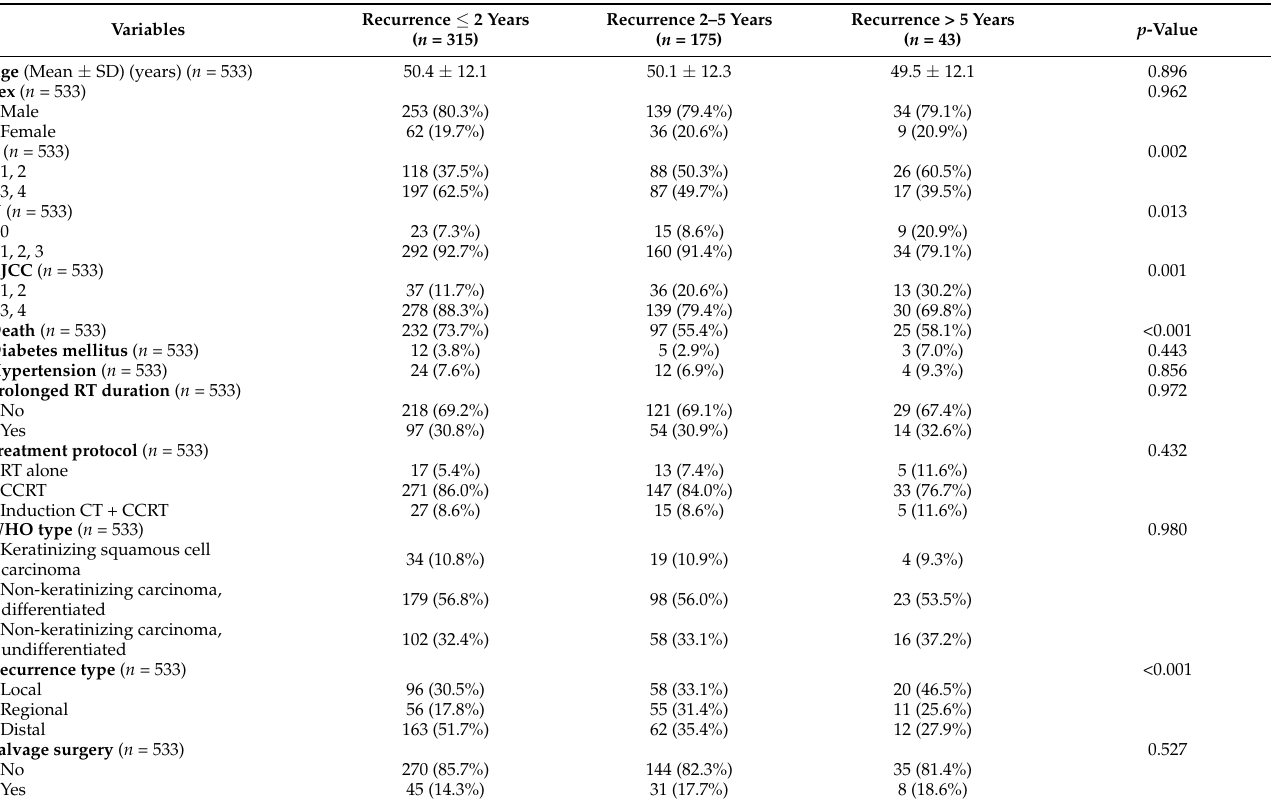
Table 3. Demographic data of recurrent groups with different time